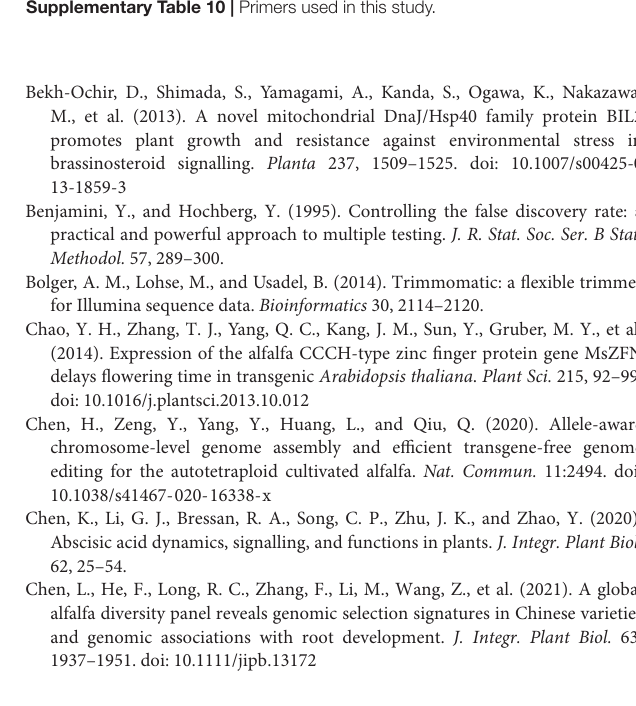
Supplementary Figure 2 | Normal distribution of the average values of the flowering time in a single year among the association panel. Supplementary Figure 3 | Correlations between different years. The correlation coefficient (R) and P value are presented at the top of the figure. (A) Correlation information in 2019 and 2020. (B) Correlation information in 2019 and 2021. (C) Correlation information in 2020 and 2021. The gray part represents the 95% confidence interval. Supplementary Figure 4 | GO analysis of all DEGs. Supplementary Figure 5 | GO analysis of the bud stage. Supplementary Figure 6 | GO analysis of the initial flowering stage. Supplementary Figure 7 | GO analysis of the full-flowering stage. Supplementary Table 1 | Significant SNPs identified via BLINK. Supplementary Table 2 | Genes associated with growth and development identified by sequence similarity. Supplementary Table 3 | Upregulated DEGs in the bud stage under normal growth conditions. Supplementary Table 4 | Downregulated DEGs in the bud stage under normal growth conditions. Supplementary Table 5 | Upregulated DEGs in the initial flowering stage under normal growth conditions. Supplementary Table 6 | Downregulated DEGs in the initial flowering stage under normal growth conditions. Supplementary Table 7 | Upregulated DEGs in the full-flowering stage under normal growth conditions. Supplementary Table 8 | Downregulated DEGs in the full-flowering stage under normal growth conditions. Supplementary Table 9 | Candidate genes identified via GWAS and a transcriptomic analysis. Supplementary Table 10 | Primers used in this